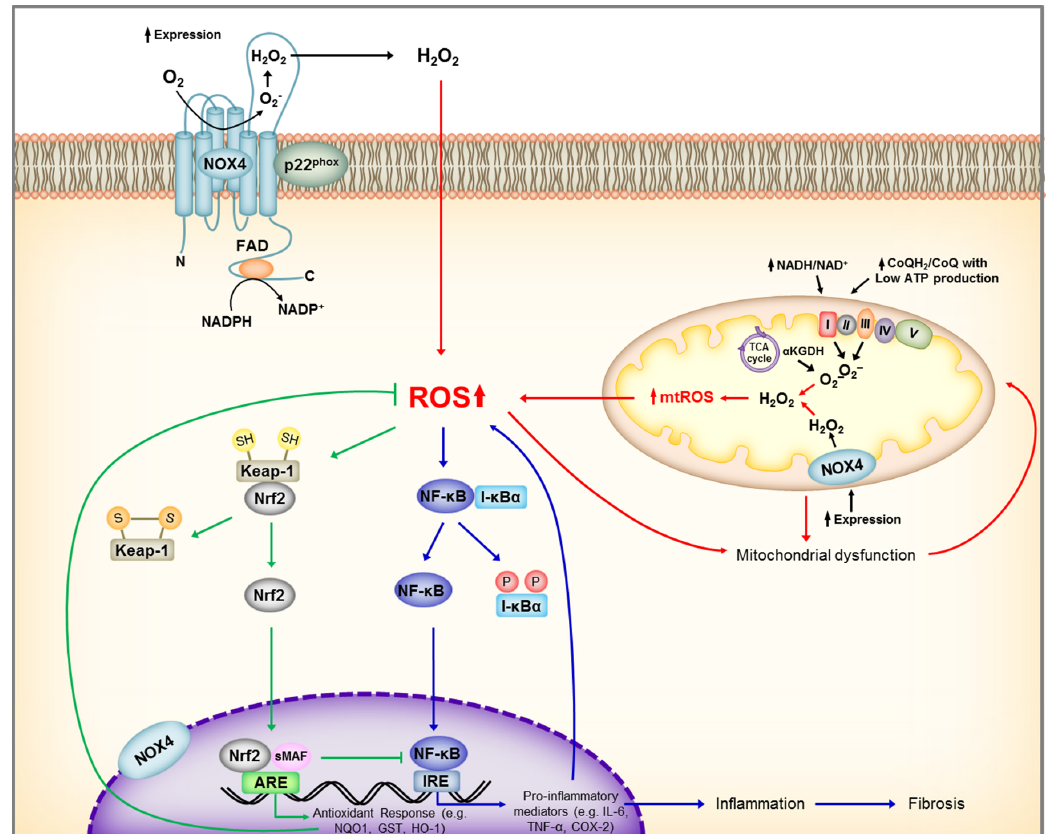
Figure 4. Schematic representation of main renal sources of reactive oxygen species (ROS) and Nrf2, NF-KB activation by ROS. Under unstressed conditions, Nrf2 is maintained in the cytoplasm through its repressor molecule, Keap1. ROS, as well as electrophilic and phenolic compounds, modify Keap-1 cysteine residues resulting in dissociation of Nrf2-Keap1 complex, and Nrf2 nuclear translocation. In the nucleus, Nrf2 dimerizes with other transcription factors, such as small Maf, and promotes transcriptional activation of antioxidant and detoxifying enzymes by binding to the antioxidant responsive elements (ARE) in the promoter regions of the target genes. At the same time, ROS activates I κ B kinase (IKK) leading to phosphorylation of the repressor molecule I- κ B, and translocation of NF- κ B to the nucleus leading to transcriptional activation of genes encoding inflammatory cytokine and chemokines. ROS, reactive oxygen species; NADP + , Nicotinamide adenine dinucleotide phosphate; NADPH, reduced form of NADP + ; NOX4, NADPH Oxidase 4; FAD, flavin adenine dinucleotide; Keap-1, Kelch-like ECH-associated protein 1, Nrf2, nuclear factor erythroid 2–related factor 2; ARE, antioxidant response element; NQO1, NAD(P)H Quinone Dehydrogenase 1; GST, Glutathione S-transferase; HO-1, Heme oxygenase-1; sMAF, small MAF SH, protein thiol of cysteine; S-S, disulfide bond; NF- κ B, Nuclear Factor kappa-light-chain-enhancer of activated B cells; P, phosphorylation; TNF- α , Tumor Necrosis Factor alpha; COX-2,